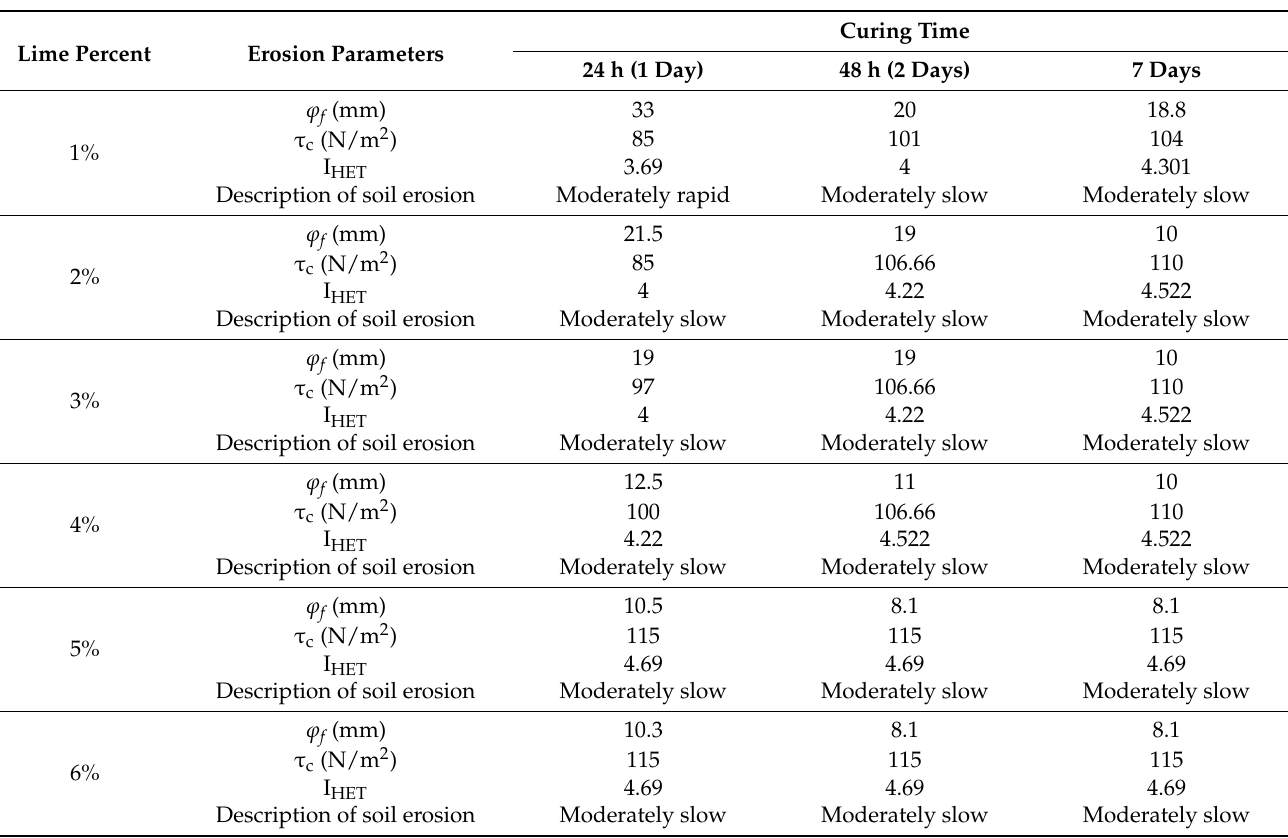
Table 4. Final erosion parameters of Soil #1.